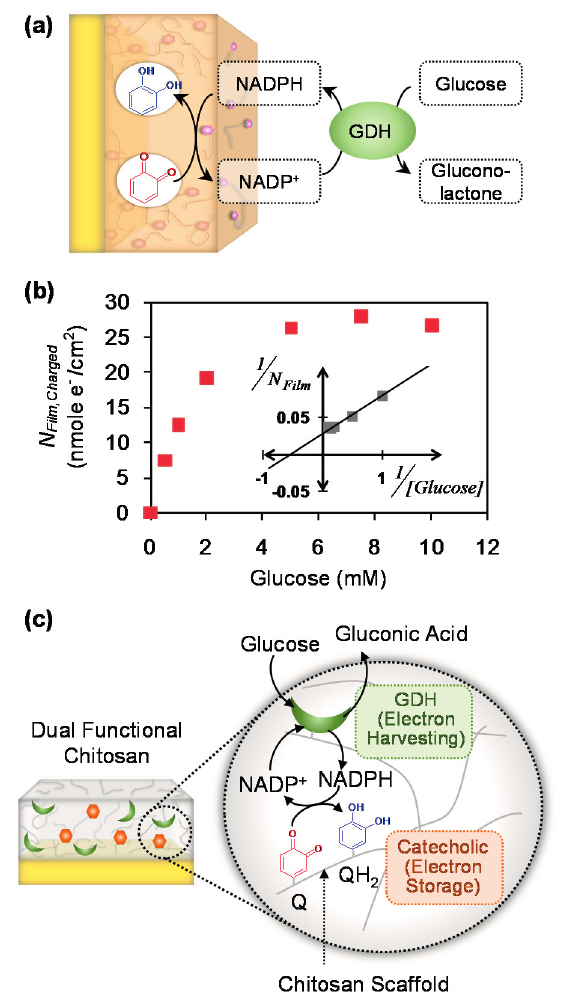
Figure 16. ( a ) Glucose dehydrogenase (GDH) catalyzed redox-cycling to charge the catechol-chitosan film; ( b ) Enzymatic charging is controlled by the electron source